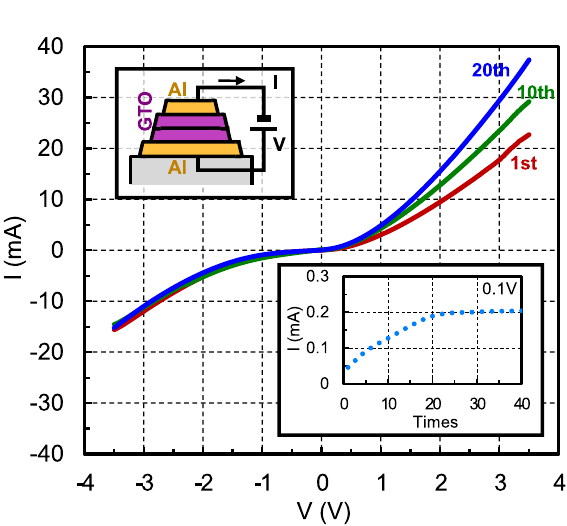
Figure 3. Analog memristor characteristic. The initial, 10th, and 20th measured electric currents are shown. It is found that the electrical conductance gradually increases when the voltage is positive.